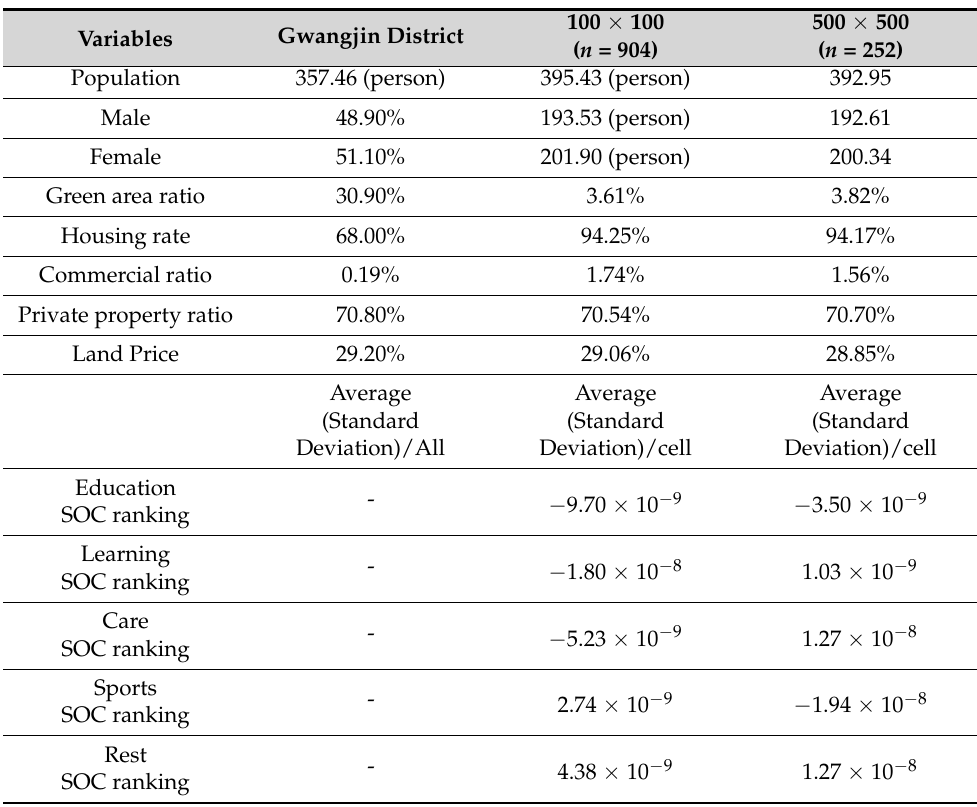
Table 4. Sample descriptive